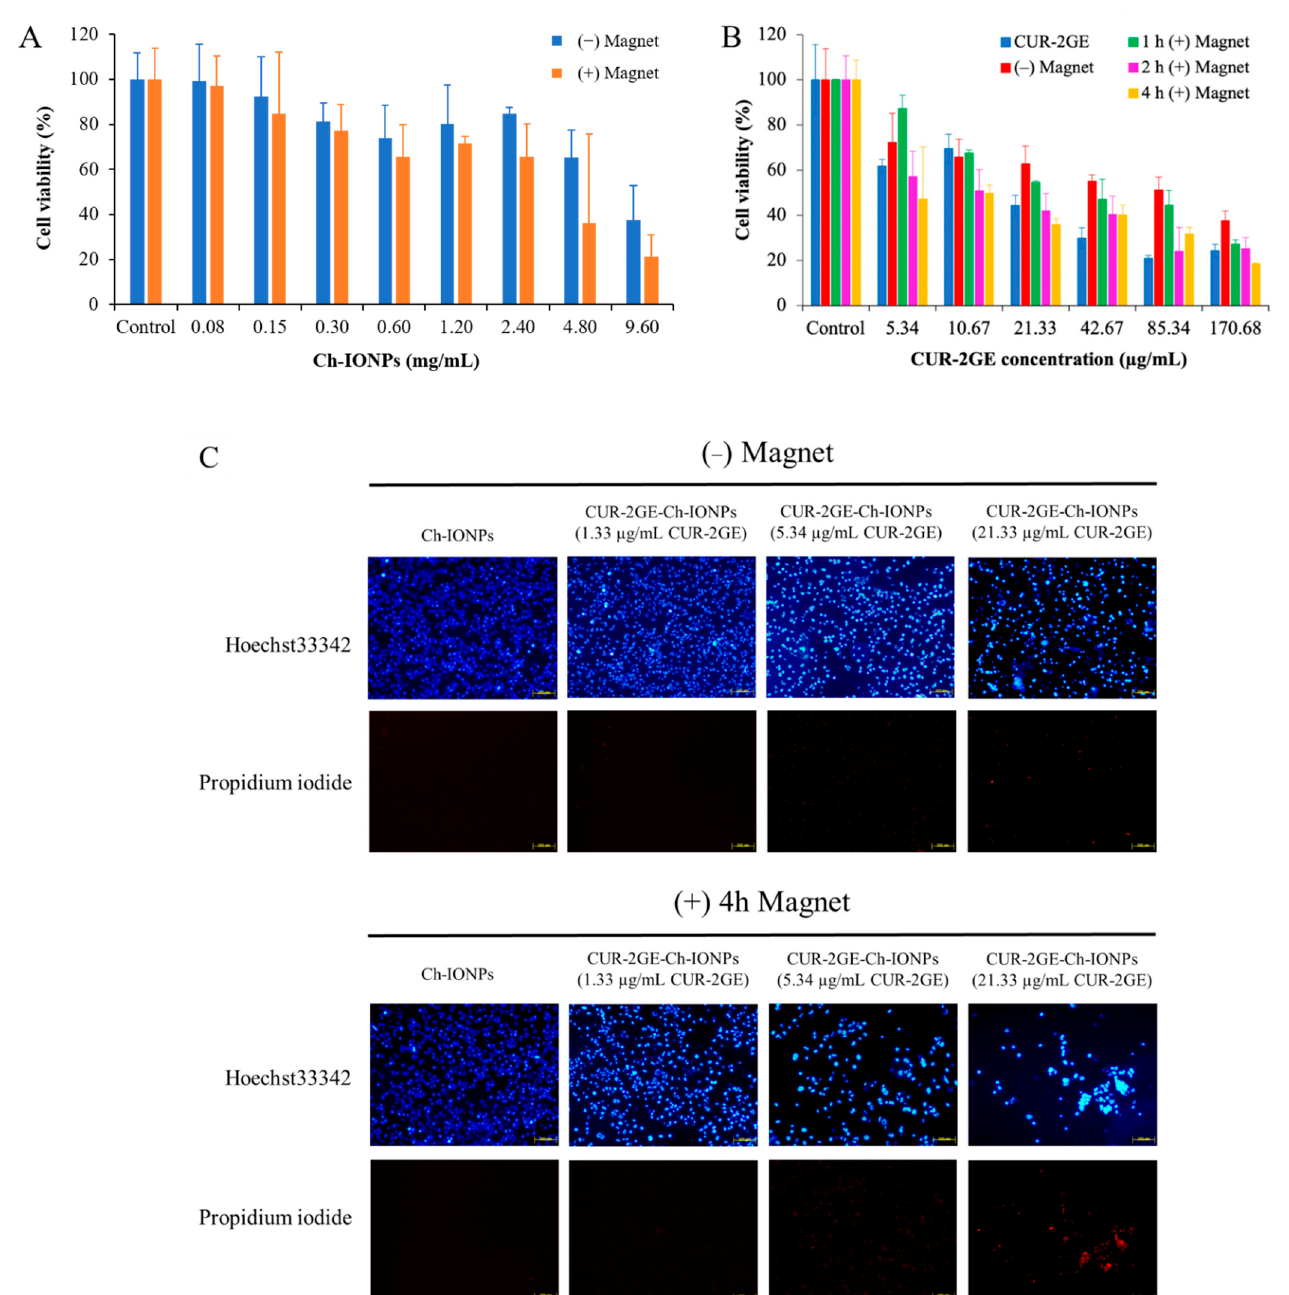
Figure 11. Cell experiments showing the viability of MDA-MB-231 treated with ( A ) Ch-IONPs, ( B ) free CUR-2GE and CUR-2GE-Ch-IONPs at various time points of exposure to the permanent magnets, and ( C ) live/dead cells staining using Hoechst-33342/propidium iodide. The designations (+) and (–) indicate the presence and absence of the permanent magnets, respectively.